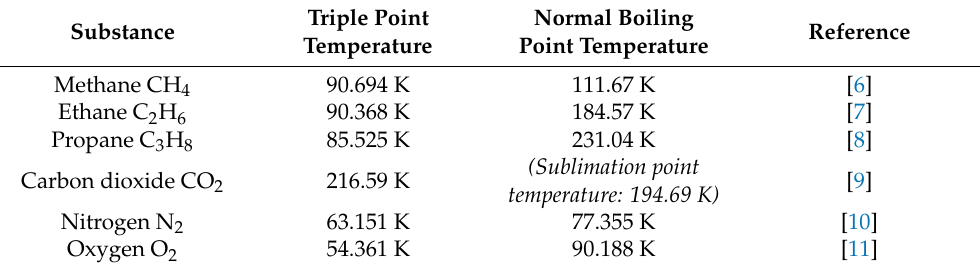
Table 1. Temperatures of triple, normal boiling points or sublimation point of natural gas components [5]. Substance